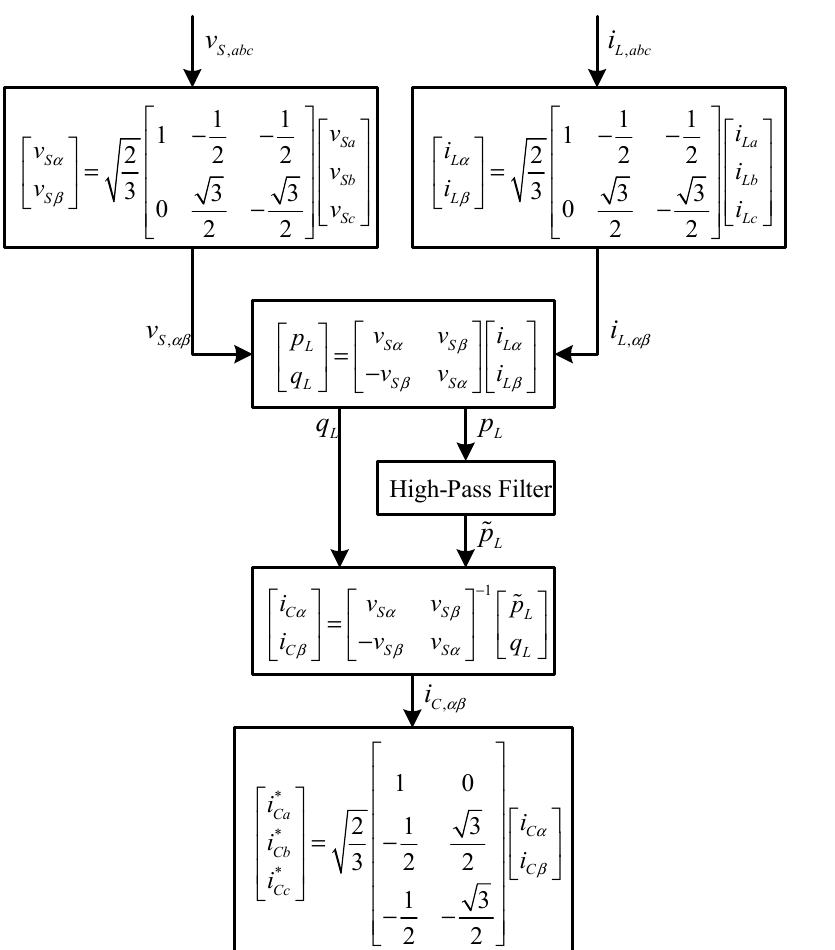
Figure 2. A computational process for harmonic detection using instantaneous power theory (Had. PQ) method.